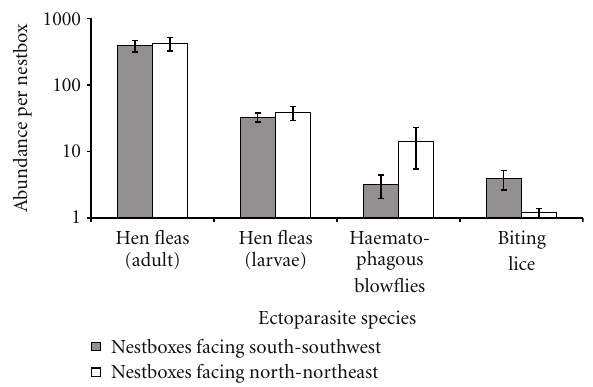
Figure 1: Mean ectoparasite abundance per nest according to nest- box orientation (error bars = SEM).